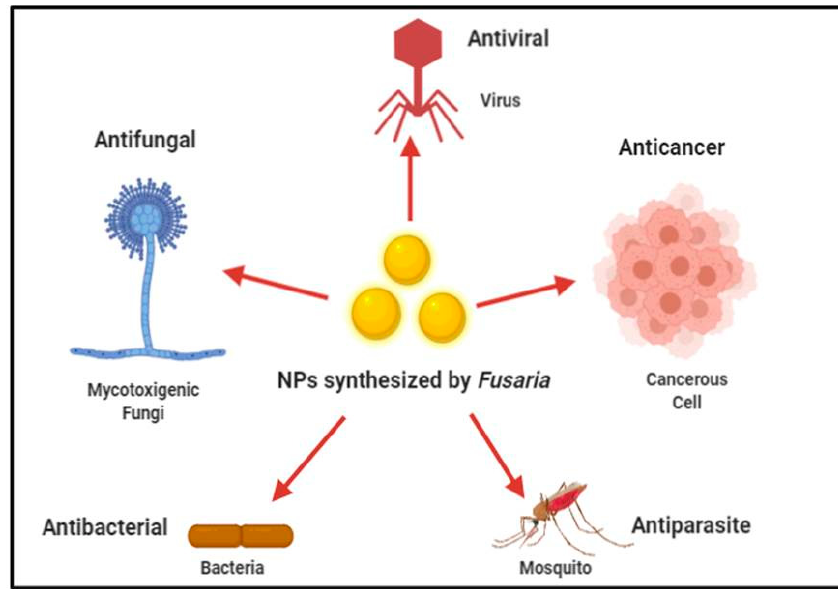
Figure 6. Biomedical applications of biogenic NPs synthesised from different Fusaria.